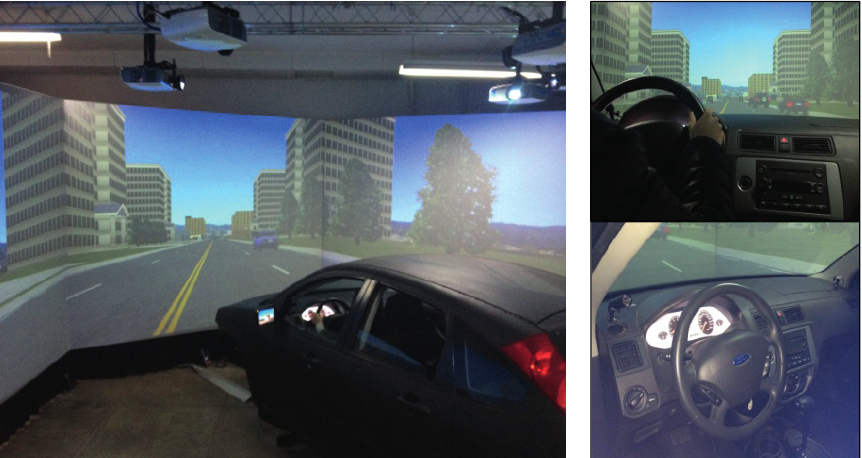
Figure 1: The driving